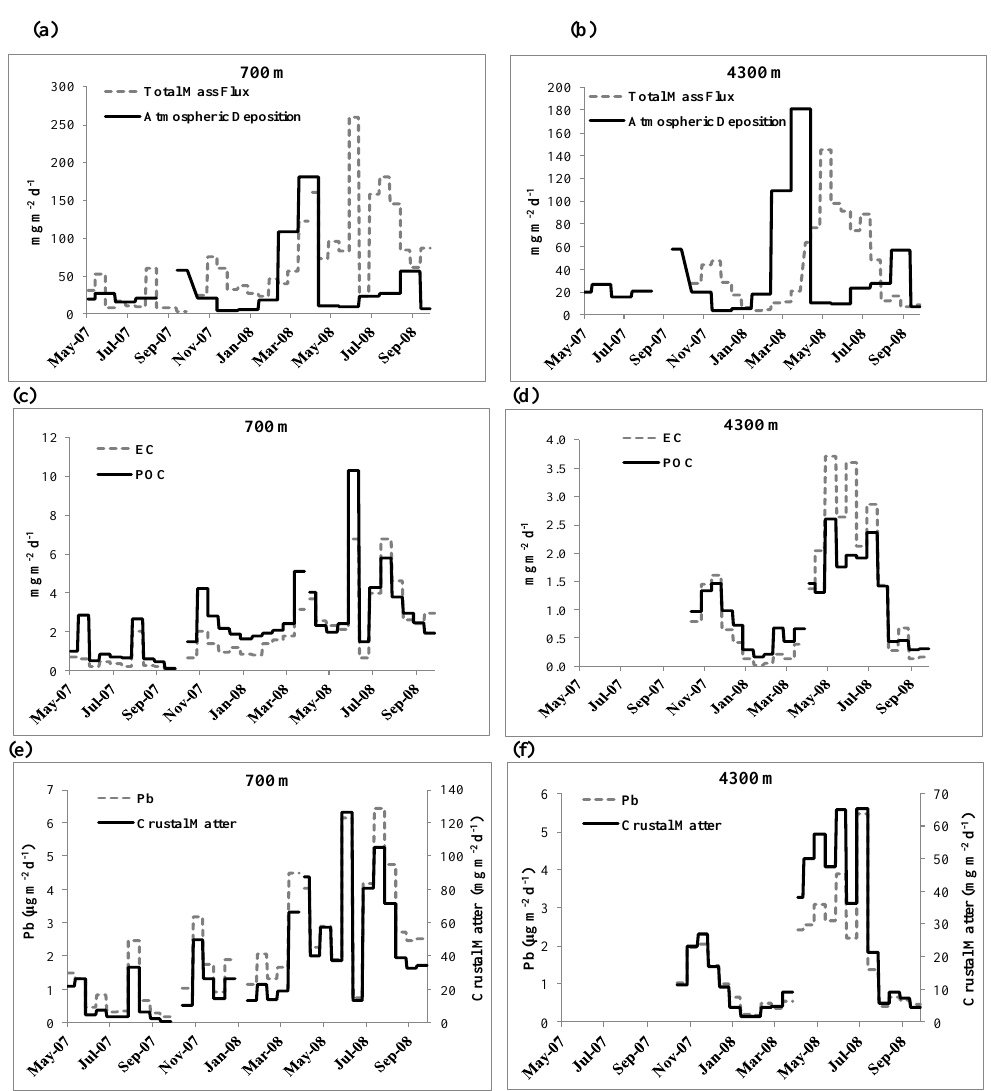
Figure 2. Time series of atmospheric deposition flux and total mass flux (Stavrakakis et al., 2013) (a, Fig. 2. Time series of total mass flux (Stavrakakis et al., 2013) and atmospheric deposition flux (a, b) , particulate organic carbon (POC) and b), particulate organic carbon (POC) and elemental carbon (c, d), crustal matter and lead at 700 m and elemental carbon flux (c, d) , crustal matter and lead flux (e, f) , at 700m and 4300m depth. Fluxes of total mass, atmospheric deposition, 4300 m depth. Atmospheric deposition flux, total mass flux, particulate organic carbon, elemental particulate organic carbon, elemental carbon and crustal matter are expressed in mgm − 2 d − 1 , whilst lead flux in µgm − 2 d − 1 carbon and crustal matter are expressed in mg m −2 d −1 , whilst lead in µg m −2 d −1 .